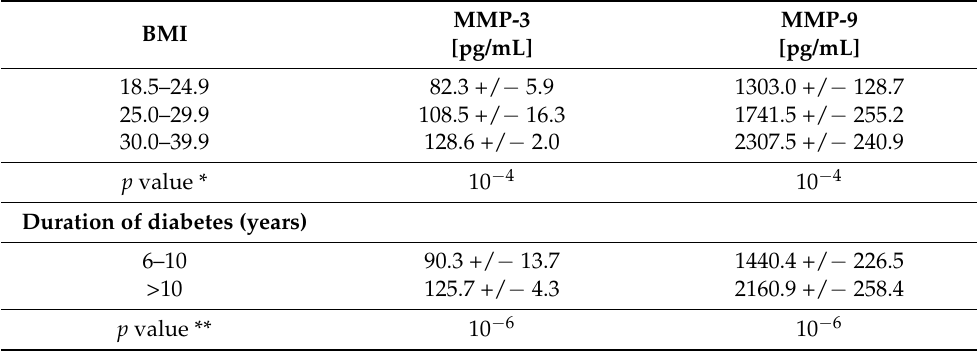
Figure 1 . Serum level of MMP-3 ( a ) and MMP-9 ( b ) in EBV-positive and EBV-negative diabetic patients (Mann–Whitney U Test ( a ) Z = 8864; p < 0.001, ( b ) Z = 6188; p < 0.001). The level of both metalloproteinases was significantly higher in patients with DM2 history longer than 10 years ( p = 10 −6 ) and in diabetic patients with obesity ( p = 10 −4 ) (Table 2). The level of MMP-3 in patients with DM2 with a history of more than 10 years was 125.7 pg/mL, while the level of MMP-9 in these patients was 2160.9 pg/mL. In patients with high BMI (30.0–39.9), the levels of MMP-3 and MMP-9 were higher (128.6 pg/mL and 2307.5 pg/mL, respectively) than in those with normal BMI (18.5–24.9) (MMP-3—82.3 pg/mL; MMP-9—1303.0 pg/mL) (Table 2). Table 2. The levels of MMP-3 and MMP-9 compared to BMI and duration of diabetes in the serum of EBV-positive diabetic patients.